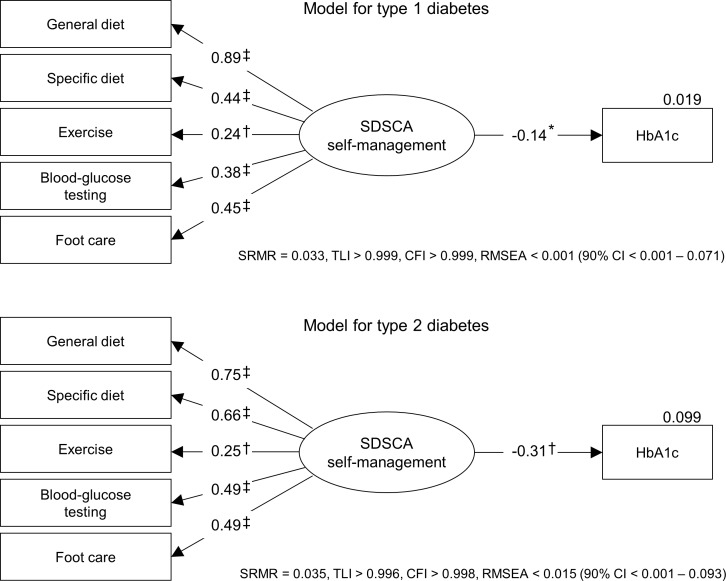
Stuctural equation model of diabetes self-management as measured by the SDSCA and glycaemic control for patients with type 1 and type 2 diabetes.Data are standardised regression weights (β) for paths or squared multiple correlations (R2) for variables. Boxes indicate manifest measurement variables; ovals indicate latent variables operationalised by manifest indicators; error terms are not displayed for ease of presentation. SRMR, Standardised Root Mean Square Residual; TLI, Tucker Lewis Index; CFI, Comparative Fit Index; RMSEA, Root Mean Square Error of Approximation. Indication of two-sided significance: * P < 0.05; † P < 0.01; ‡ P < 0.001.